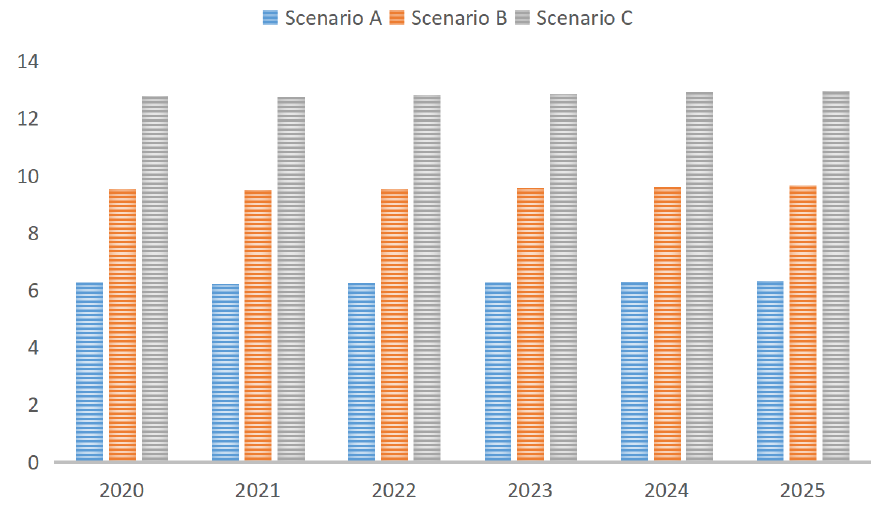
Figure 9. Total carbon emissions generated under different depletion rates (10,000 tons).